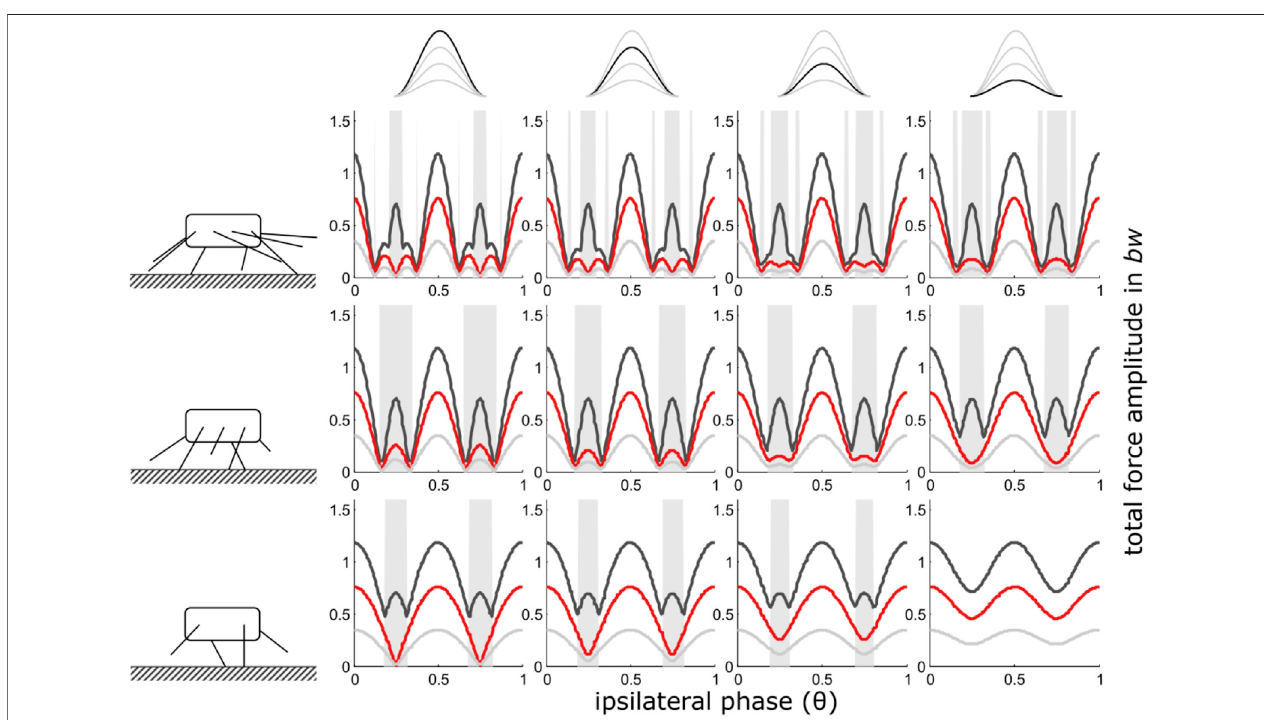
FIGURE 2 | Constant contact durations (i): Dependency of total vertical leg force amplitudes on the phase shift of ipsilateral adjacent legs and duty factor with graduallydecreasingcontributionsofincreasingnumbers ofleg pairs. Dutyfactorsshown:0.3(darkgrey),0.5(red) and0.8(lightgrey).Thetoprow indicates thedegree ofreductioninthepairoflegswithreducedGRFandthetypeofforcealignment(here(i)).Accordingly, inthethirdcolumnfromtheright,theimpulsebeneathonelegpair is reduced by ¼, in the 2 nd column from the right by ½ and in the rightmost column by ¾. The pictograms to the left indicate the number of propulsive pairs of legs validfortherespective rowofsubplots,i.e.four intheupper row, threeinthemiddle rowand twointhebottom row.With lowdutyfactors andintermediatephase shifts, the peak frequency of the force oscillations can deviate from two times the stride frequency; these intervals are shaded in grey.